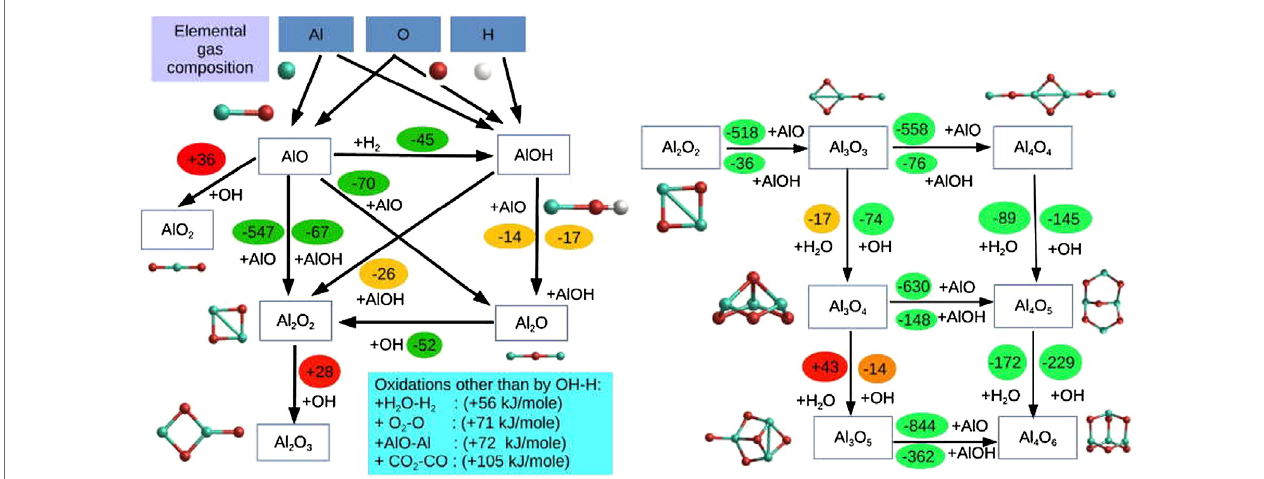
FIGURE4| Reactionschemefortheformationofthealuminamonomer(left)anddimer(right).ReactionenthalpiesaregiveninkJ mol − 1 .Veryexothermicreactions are colour-coded in green, slightly exothermic reactions in orange, and endothermic reactions in red. The molecular structures of the aluminum-bearing species are indicated (blue is aluminum, red is oxygen). Figure taken from Gobrecht et al.